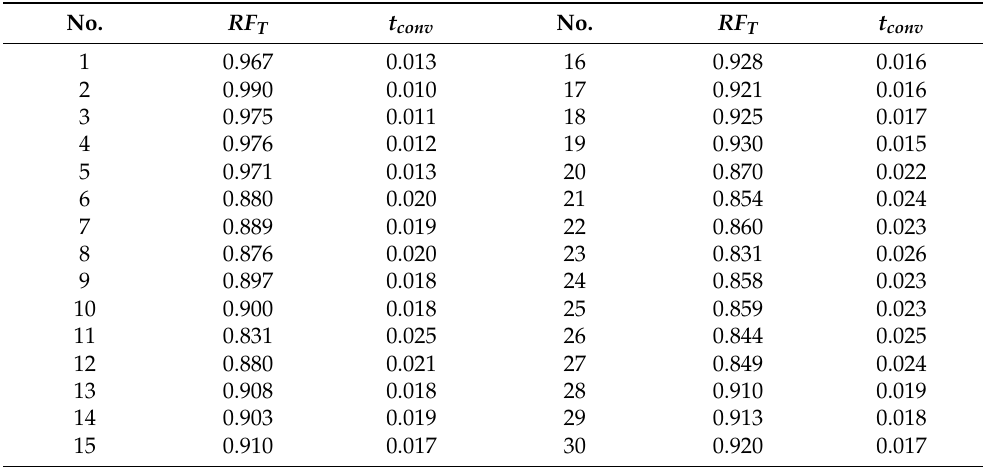
Table 4. Executions performed by SA for a 41 × 41 mesh and a residual value of ε = 1 × 10 − 5 , for the convection-diffusion problem.